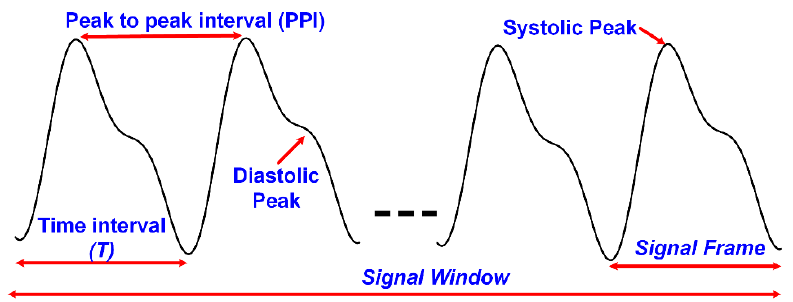
Figure 7. PPG waveform and its basic features.